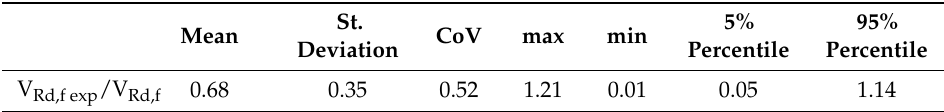
Table 7. Statistical values of the predictions: mean, Standard deviation, Coefficient of Variation,